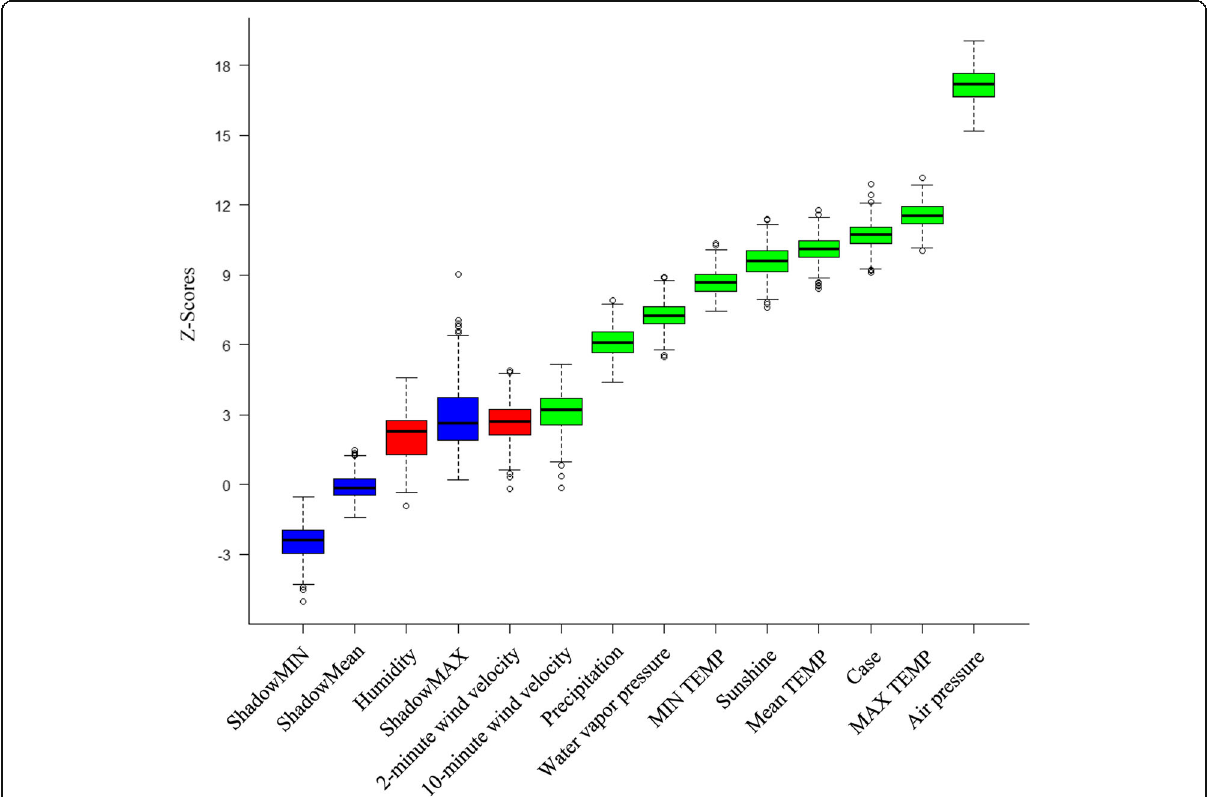
Fig. 6 Nine variables confirmed to be important: air pressure, max TEMP (temperature), mean TEMP, MIN TEMP, sunshine, water vapour pressure, precipitation, 10-min wind velocity and case. Note: The Z-score shows the importance of variables. The shadow variable is a random variable whose value is generated by permuting the original values across observations